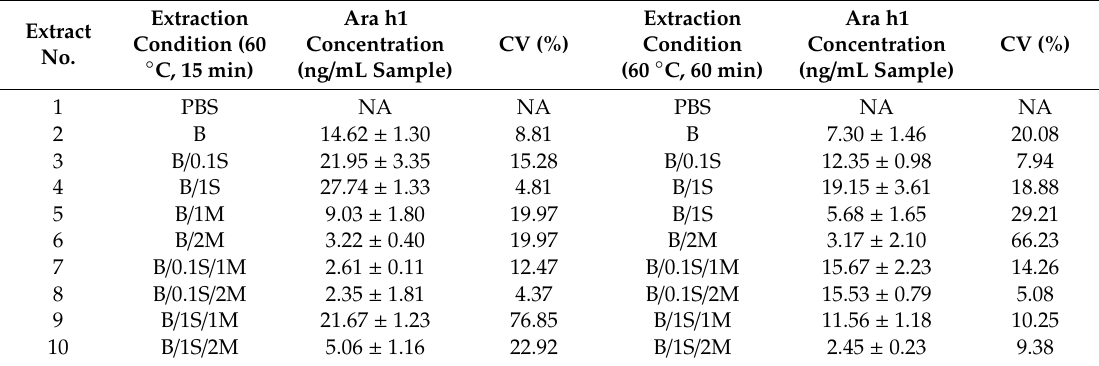
Table 1. E ff ect of temperature (60 ◦ C) and time (15 min, 60 min) on Ara h 1 extraction from commercial peanut butter food sample according to the extraction condition